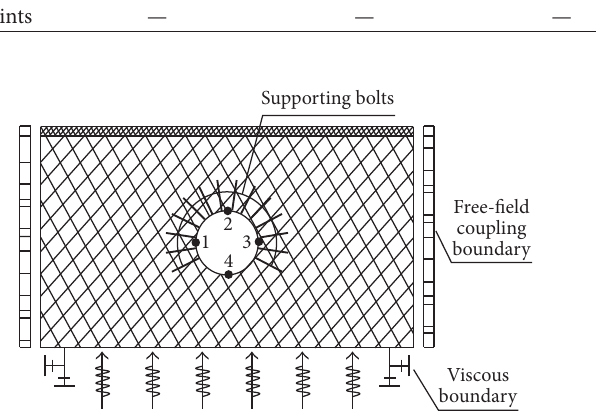
Figure 10: DDA model of Xianglushan Tunnel under seismic loading.